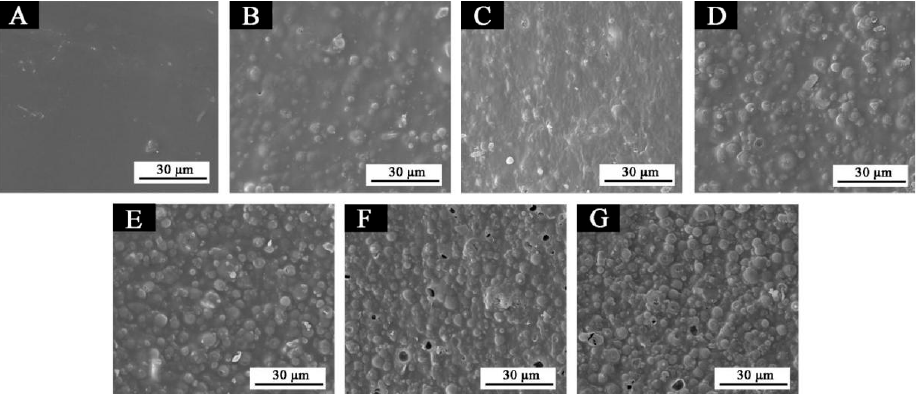
Figure 5. SEM of topcoats with different concentrations of fluorane microcapsules: ( A ) 0%, ( B ) 5%, ( C ) 10%, ( D ) 15%, ( E ) 20%, ( F ) 25%, ( G ) 30%. The FTIR spectra of the coatings with various fluorane microcapsule contents are shown in Figure 6. At 3340 cm − 1 , the tensile vibration absorption of -NH and -OH were superimposed. C-O-C absorbed stretching vibrations at 1153 cm − 1 , and CH 2 had a stretching vibration peak at 1440 cm − 1 . A strong carbonyl characteristic absorption was present at 1730 cm − 1 , while the tensile vibration of -CH 3 was present at 2910 cm − 1 . The triazine ring’s peak for both stretching and bending vibration absorption was found to be at 1584 cm − 1 and 816 cm − 1 , respectively. No peak disappeared or appeared when fluorane microcapsules were added to the topcoat. The thermochromic effect can still occur when fluorane microcapsules are added to the basswood surface waterborne topcoat layer, proving that there was no chemical reaction between fluorane microcapsules and the topcoat on the wood’s surface.